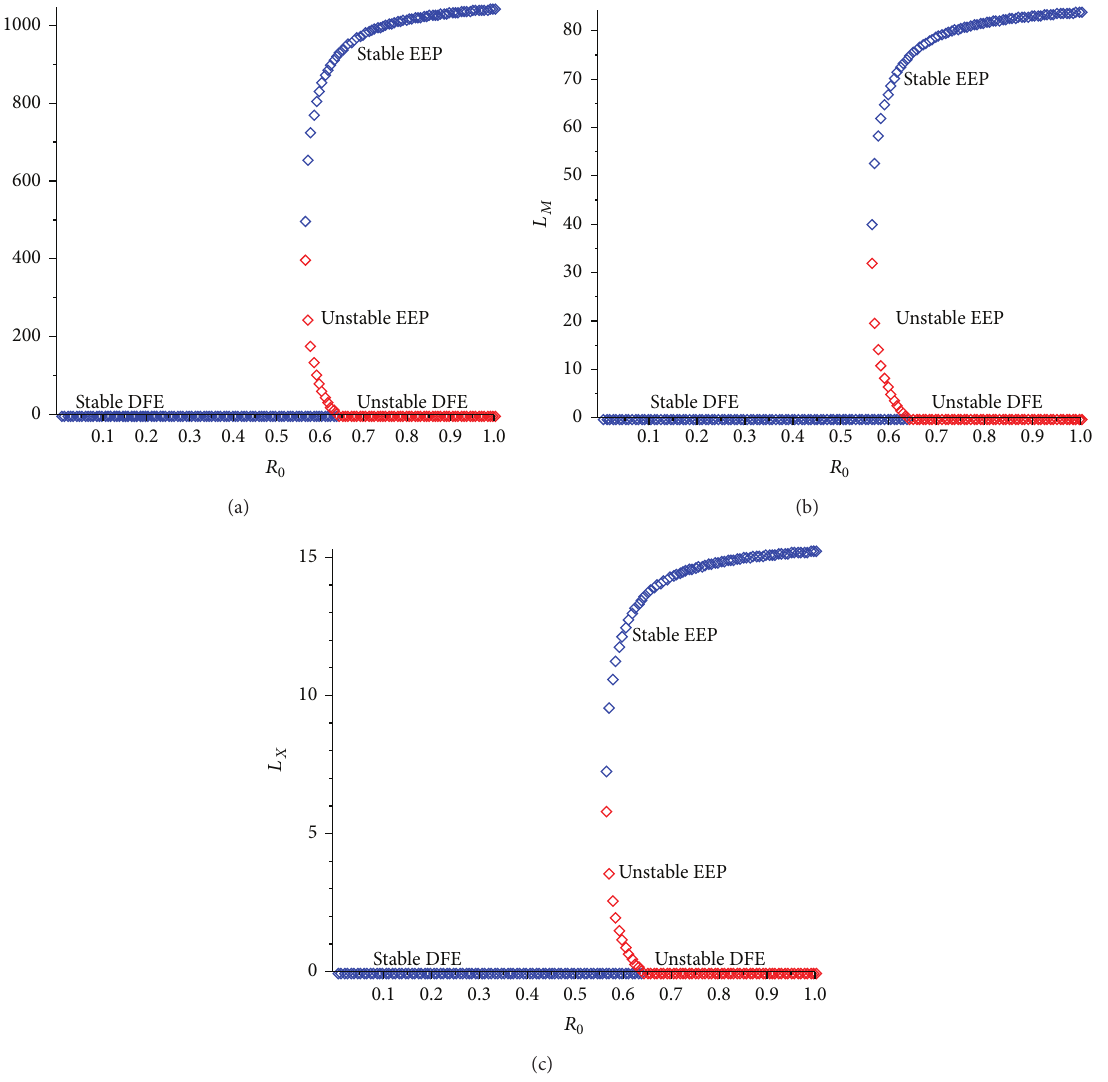
Figure 6: Backward bifurcation plot of model (2) as a function of time. (a) Individuals who are lost to follow-up with drug sensitive TB ( 𝑇 ). (b) Individuals who are lost to follow-up with MDR ( 𝑀 ). (c) Individuals who are lost to follow-up with XDR ( 𝑋 ). Parameter values used are as given in Table